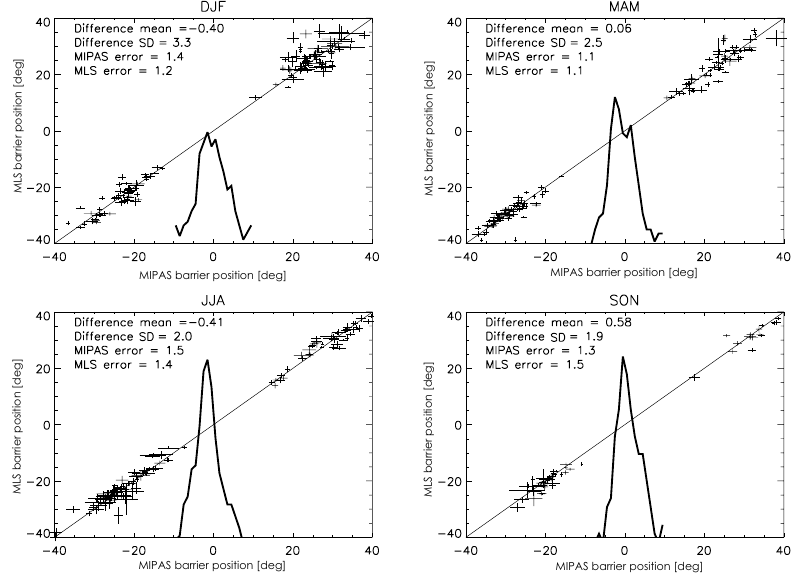
Figure A2. Correlation of latitudinal positions of the subtropical transport barriers (crosses) for the levels between 520 and 830K, derived from MIPAS (horizontal axis) and MLS (vertical axis), respectively, for four seasons; the horizontal and vertical extensions of the crosses denote the 1 σ uncertainties of the transport barrier positions from MIPAS and MLS, respectively. The solid curve is the PDF of the position differences between MLS and MIPAS. The legends provide the mean and the standard deviation of the differences of the barrier positions derived from the two data sets, and the average uncertainties of the positions from MIPAS and MLS data, respectively, derived from the support statistics (see Fig. A1).